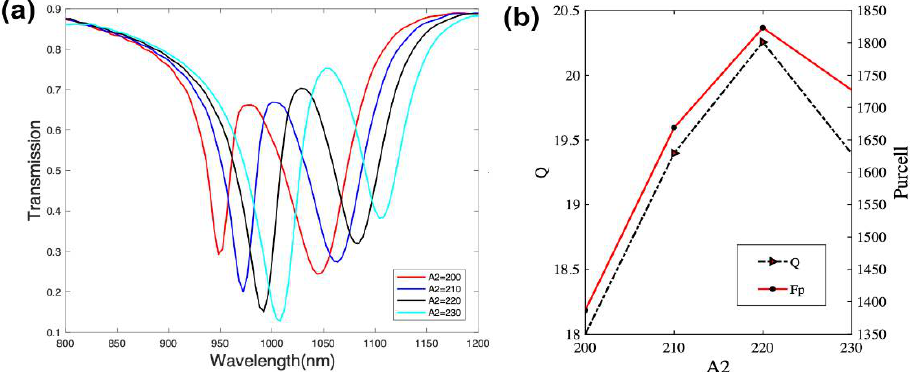
Figure 4. The transmission spectrum ( a ) and Q /Purcell factors ( b ) corresponding to varying A 2 .